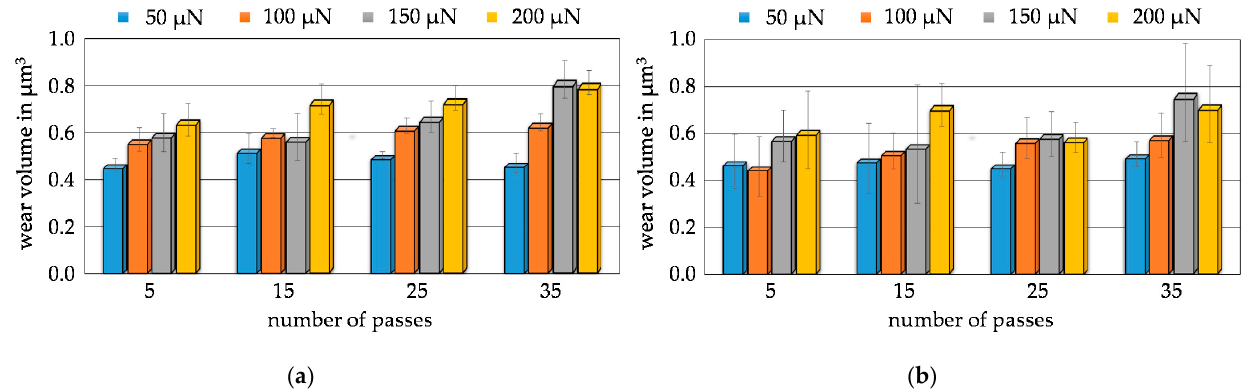
Figure A1. Determined wear volumes with standard deviation of the respective parameter combination. ( a ) Volume determination via subtraction of post ‐ scan and pre ‐ scan of the Mo ‐ coating. ( b ) Volume determination only via post ‐ scan of the Mo ‐ coating.